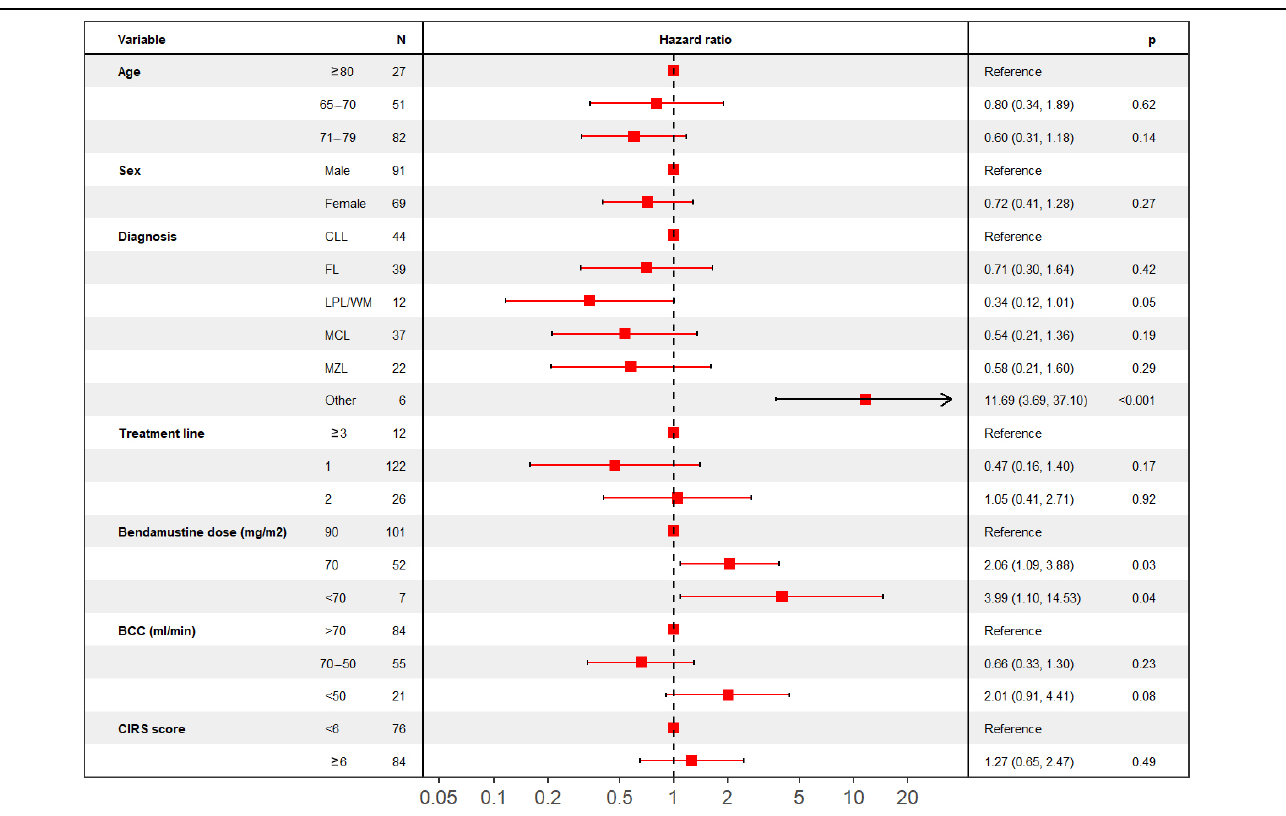
Figure 5. Multivariable analysis for TTP. Forest plot describing multivariable analysis results for TTP.